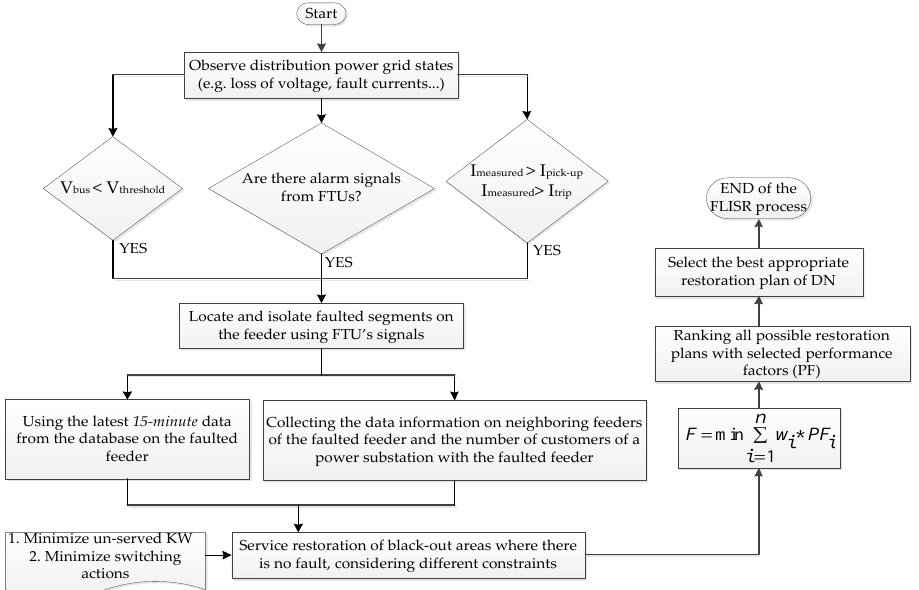
Figure 3. Flow diagram of a proposed FLISR approach for smart distribution networks.